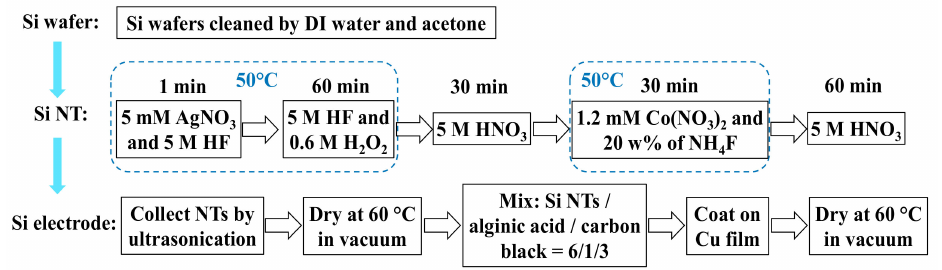
Figure 1. Synthesis of SiNT and battery